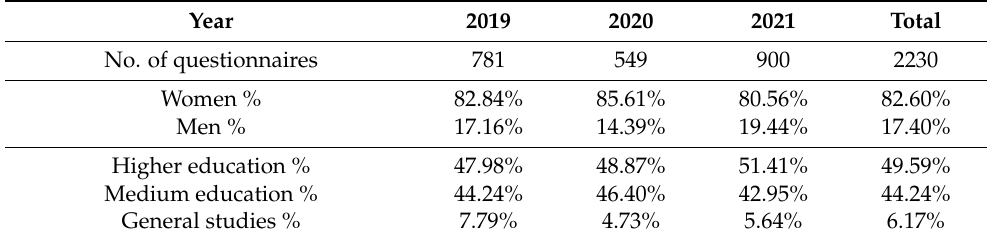
Table 1. Distribution by year, gender and education level of the analyzed questionnaires.